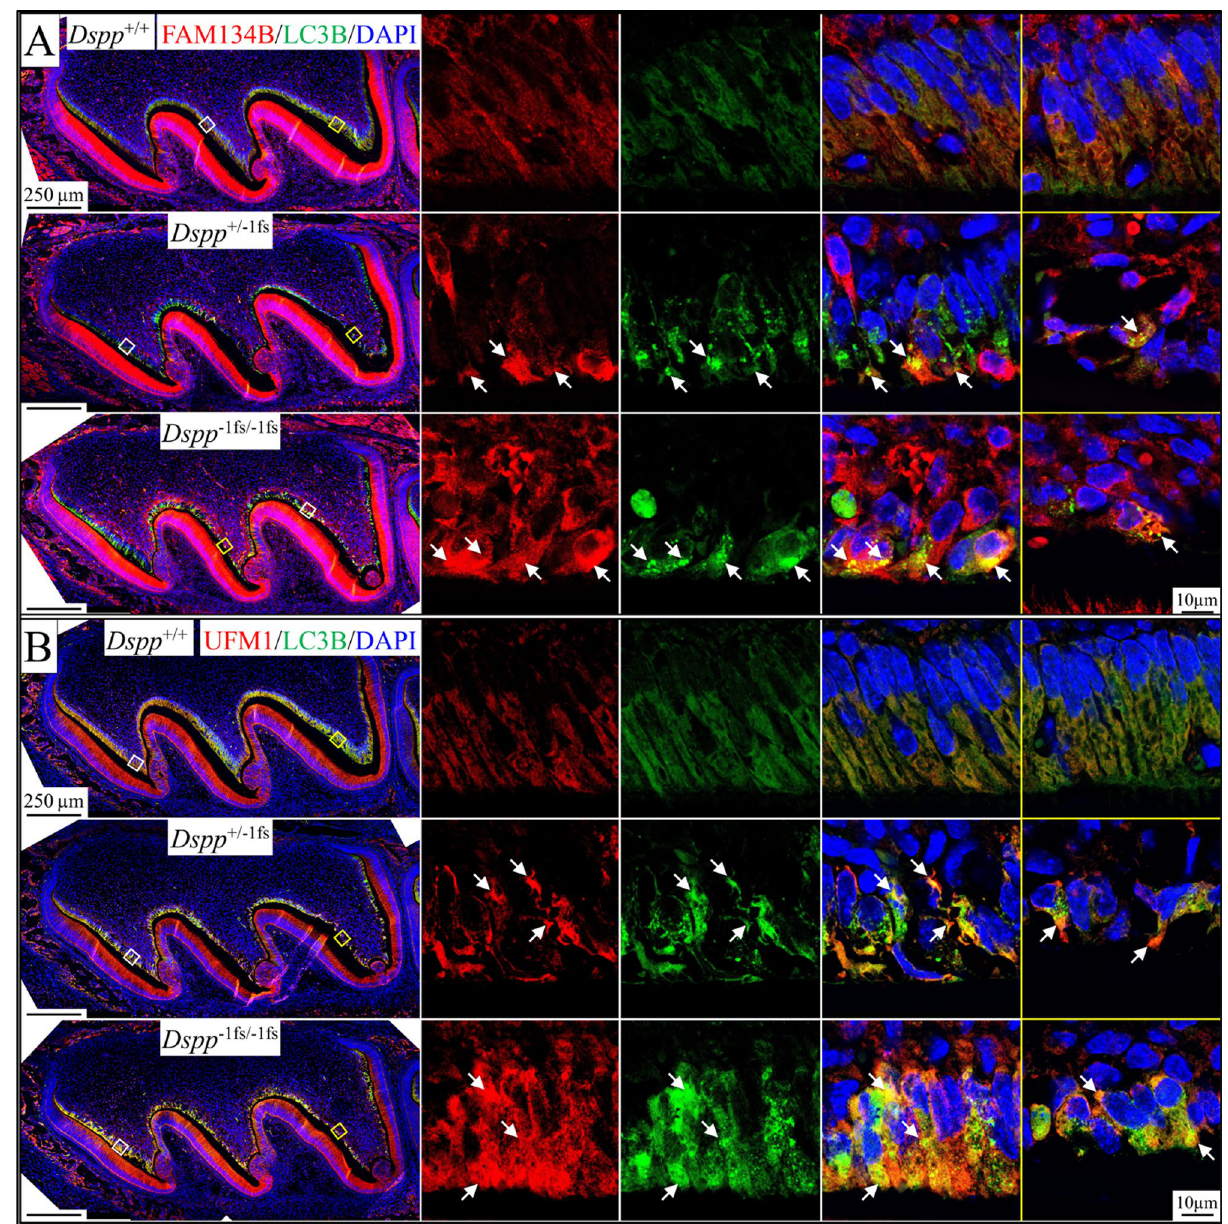
Figure 9. ER-phagy activity in the Dspp −1fs odontoblasts. Immunohistochemistry on the D3 maxillary 1st molars, showing FAM134B (red; ER-phagy adaptor) or UFM1 (red; UFMylation), LC3B (green; autophagic vacuoles), and DAPI (blue; nucleus). Two box areas (with white and yellow outlines) are shown at higher magnification on the right. Individual signals from each antibody and merged signals are shown for white outline areas. Only merged signals are shown for yellow outline areas. ( A ) FAM134B signal distributed throughout the cytoplasm of Dspp +/+ odontoblasts. FAM134B signal congregated regionally in Dspp −1fs odontoblasts, partially overlapping the LC3B signal (arrows). ( B ) UFM1 signal was detected in odontoblasts, ameloblasts, and bone cells. UFM1 signal was distributed evenly throughout Dspp +/+ odontoblast cytoplasm. In Dspp −1fs odontoblasts, UFM1 signal congregated regionally, partially overlapping the LC3B signal (arrows). Scale bars: 250 μm (left)/10 μm